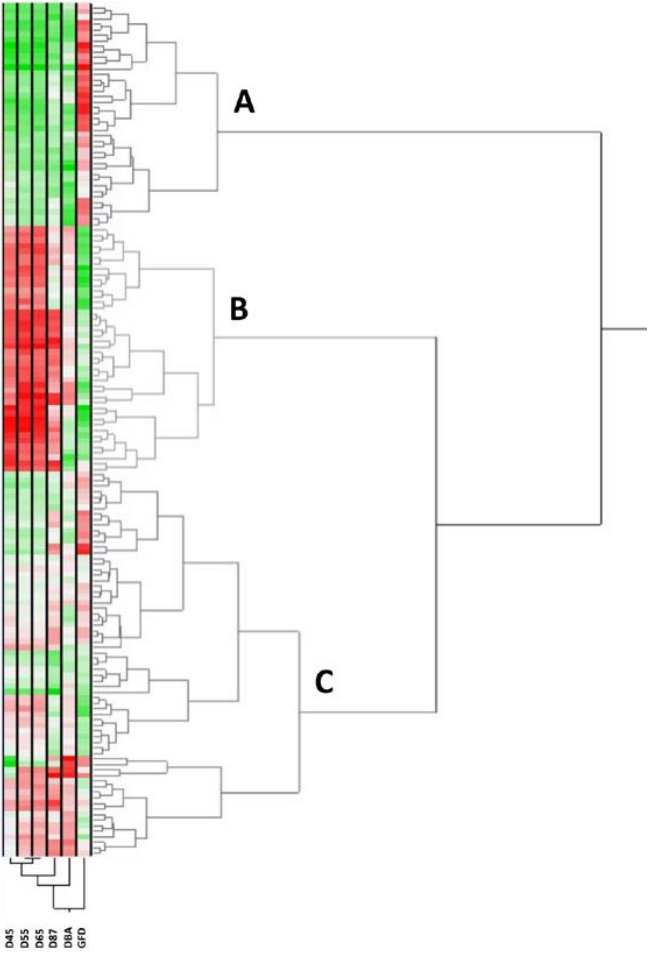
Figure 1. Bidimensional clustering showing the phenotypic relationships between the 153 bread wheat landraces based on the traits specified in the vertical cluster at the bottom. Red and green colours in the columns indicate high and low values, respectively. Dark, higher values; light, lower values; white, intermediate values. D45 (boots swollen), D55 (heading), D65 (anthesis), D87 (physiological maturity), DBA (days from booting to anthesis) and GFD (grain filling duration).